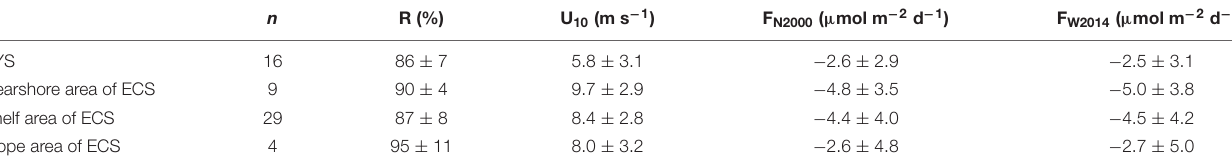
TABLE 3 | Overview of surface N 2 O saturation (R), wind speed (U 10 ), and N 2 O sea-to-air flux (F) in the SYS, and the nearshore, shelf, and slope area of the ECS.